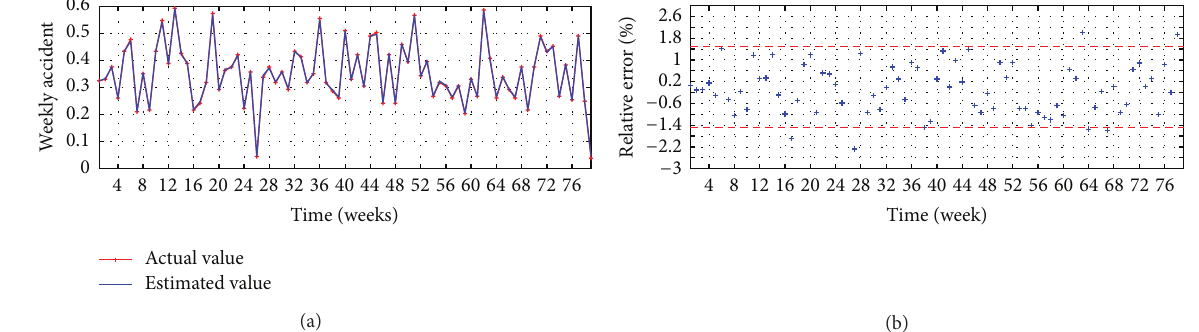
Figure 4: MA-ARIMA(9,0,10), (a) observed versus estimated (b) relative